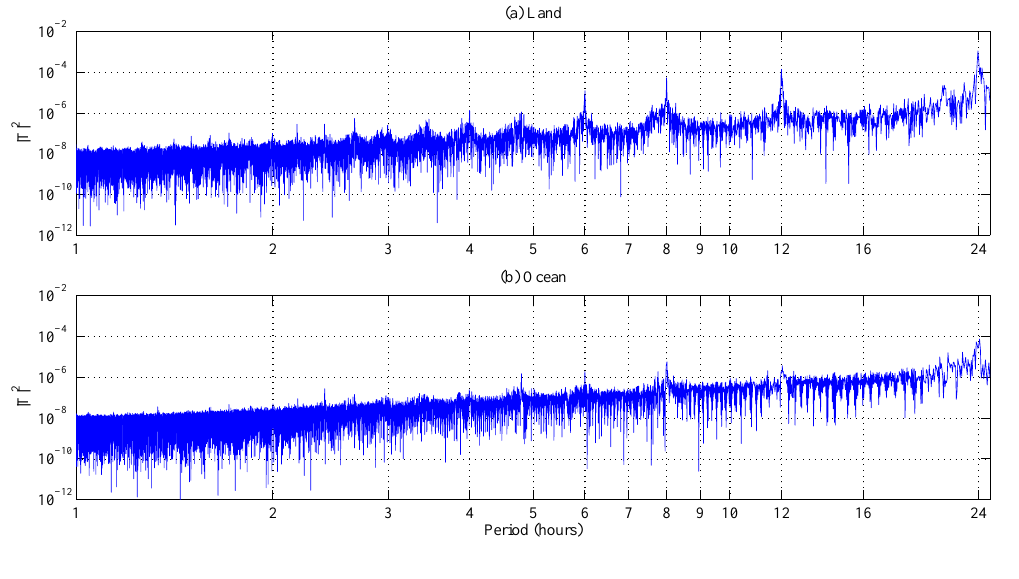
Figure 9. Power spectrum of the Nature Run time series of mean ( a ) land; and ( b ) ocean cloud fraction for 1 June 2006 at 0000 UTC to 1 December 2006 at 0000